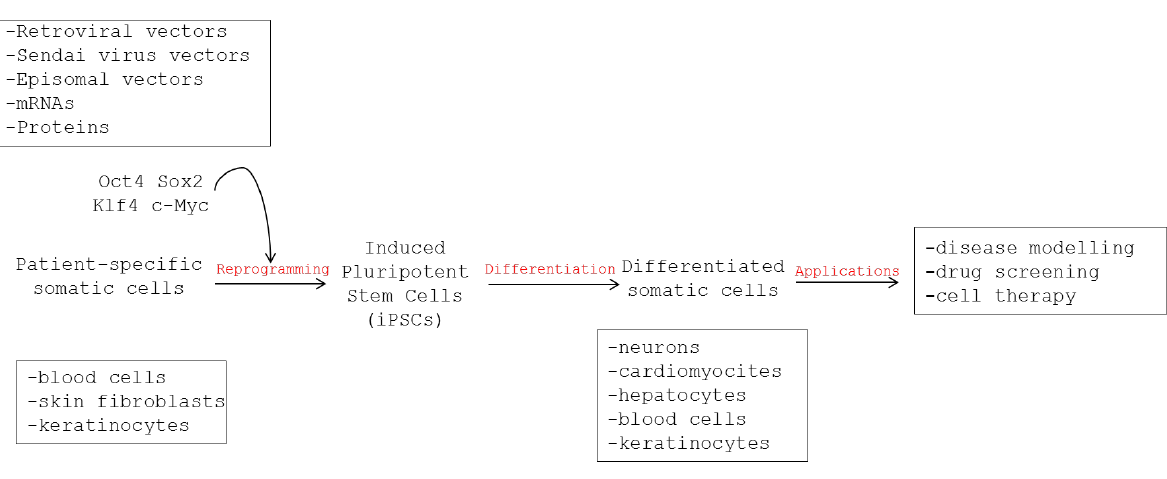
Figure 1. Representation of the workflow for the derivation of patient-specific induced pluripotent stem cells, their differentiation in somatic cells and tissues, and their use for disease modeling, drug screening, and development of personalized